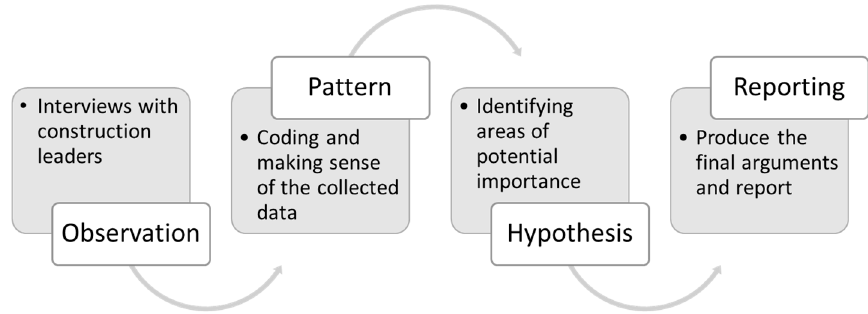
Figure 1. Process of the inductive reasoning adopted.